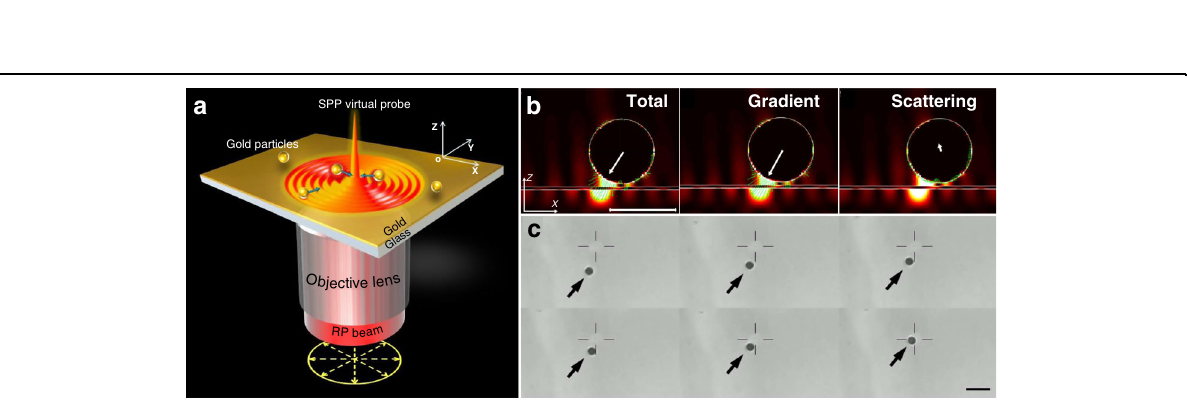
Fig. 9 Focused plasmonic trapping of metallic particles. a Schematic of trapping of metallic particles by an SPP virtual probe. Plasmons are excited on a smooth metallic fi lm through the use of a highly focused laser beam at the position that satis fi es the coupling conditions and propagate to generate a stable plasmonic fi eld after interference. b Plasmonic forces act on the particle located in the plasmonic fi eld, and c successive experimental results of gold particles (diameter of 1 ± 0.1 μ m) trapped by the focused plasmonic tweezers. Figure is reprinted with permission